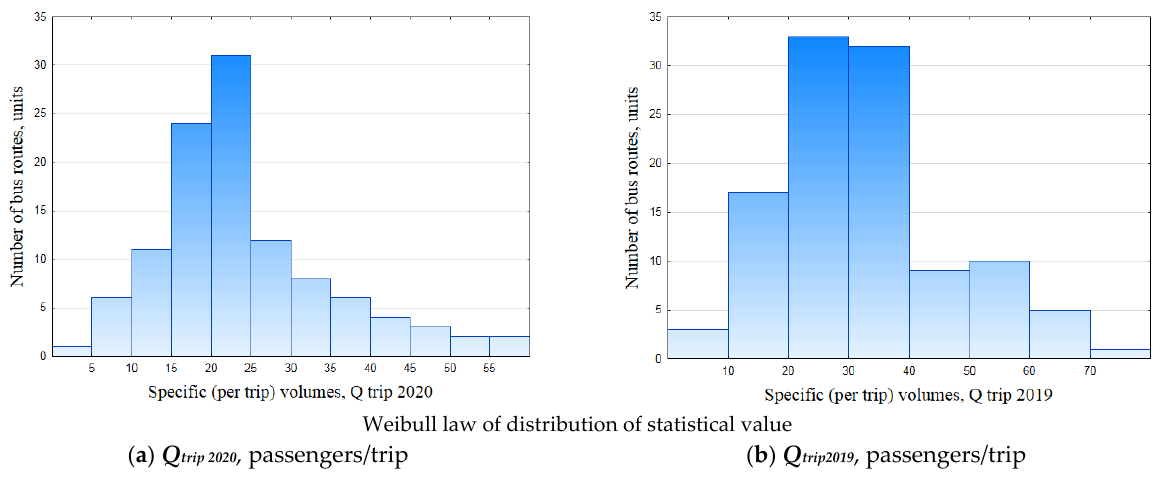
Figure 10. Distribution of values of the relative number of passengers Q trip transferred on Tyumen CPPT bus routes, per trip, in 2020 and 2019.